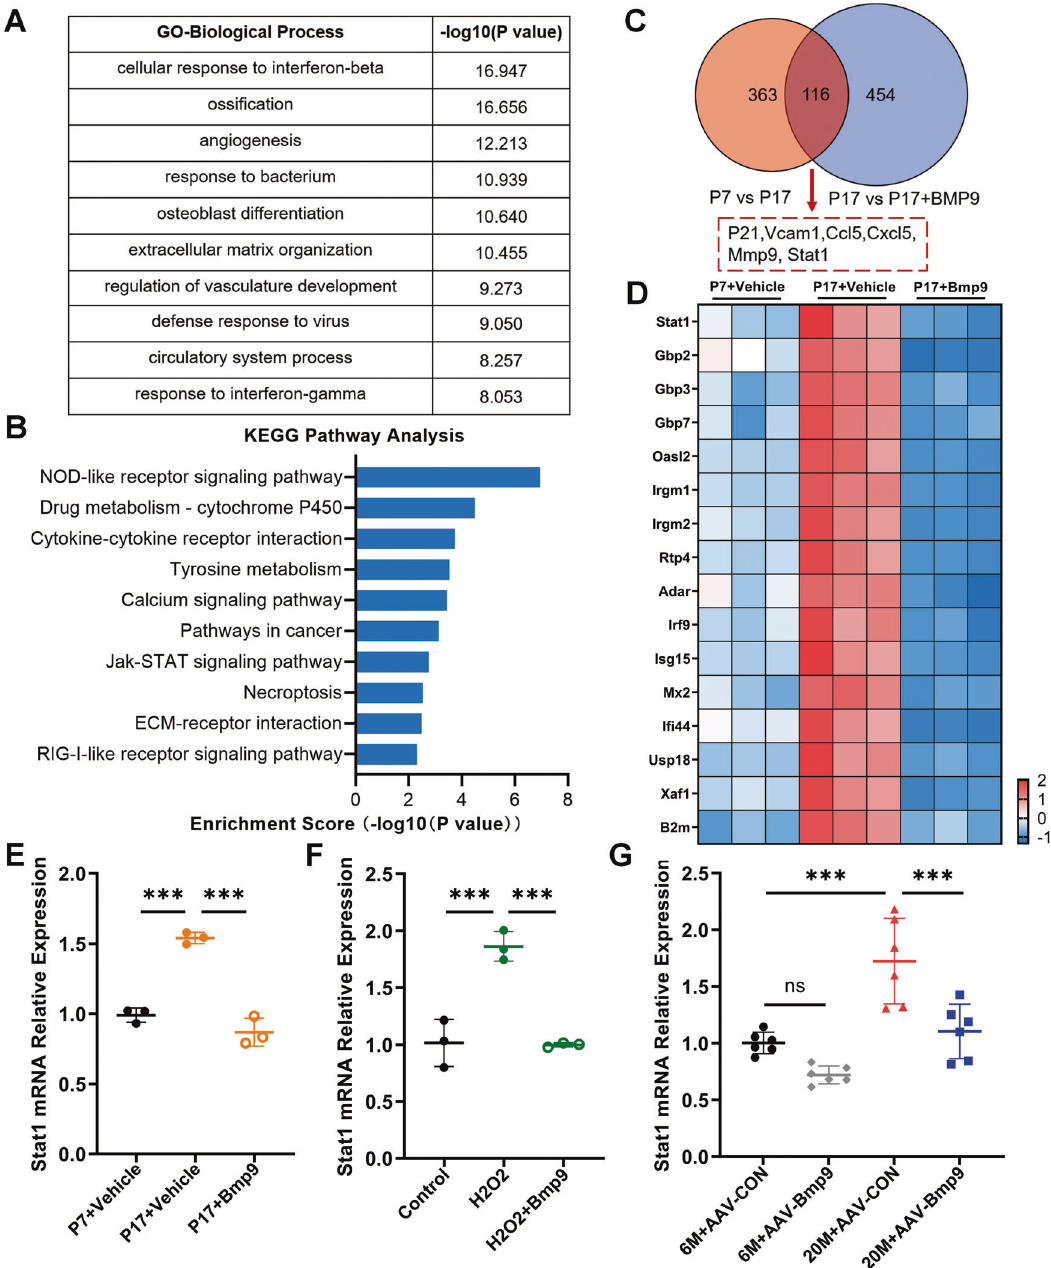
Fig. 5 Stat1 is a key factor in regulating senescence of osteoblast. A GO analysis of differentially expressed genes between replicative senescent MC3T3-E1 cells treated with vehicle or BMP9 for 3 days. B Top 10 downregulated pathways in KEGG analysis. C Overlap analysis of upregulated genes between normal control with replicative senescent MC3T3-E1 cells and downregulated genes between senescent MC3T3-E1 cells treated with vehicle or BMP9. D Heatmap of Stat1 and its downstream target genes in passage 7 and passage 17 of MC3T3-E1 treated with vehicle or BMP9 for 3 days. E qPCR analysis of mRNA level of Stat1 in cells of passage 7 and passage 17 with vehicle or BMP9 treatment for 3 days. F qPCR analysis of mRNA level of Stat1 in control and H 2 O 2 -stimulating MC3T3-E1 cells treated with vehicle or BMP9 for 3 days. G qPCR analysis of mRNA levels of Stat1 in 6-month-old and 20-month-old mice treated with AAV-CON or AAV-BMP9 ( n = 6). Data presented as mean ± SD. n = 3 biological replicates for in vitro experiment. One-way ANOVA was used for comparison among multiple groups. * P < 0.05; ** P < 0.01; *** P < 0.001. Ns, no signi fi manifested by increased expression of Hmgb1, Nfkb1, and Vcam1 To further investigate the effect of Smad1 inhibition in vivo, (Fig. 8K). Furthermore, the expression of osteoblast-speci fi c genes aged mice with BMP9 overexpression were treated with in vertebrae of aged mice was upregulated by BMP9 and LDN193189 injection. The decreased expression of P21 and Stat1 downregulated by LDN193189 (Fig. 8L). Micro-CT showed that in the bone of BMP9-overexpressed mice was upregulated by LDN193189 eliminated the improvement on bone mass and LDN193189 intervention (Fig. 8J). In addition, LDN193189 reversed trabecular microarchitecture of aged mice caused by BMP9 the inhibitory effect of BMP9 on SASPs in vivo, which was